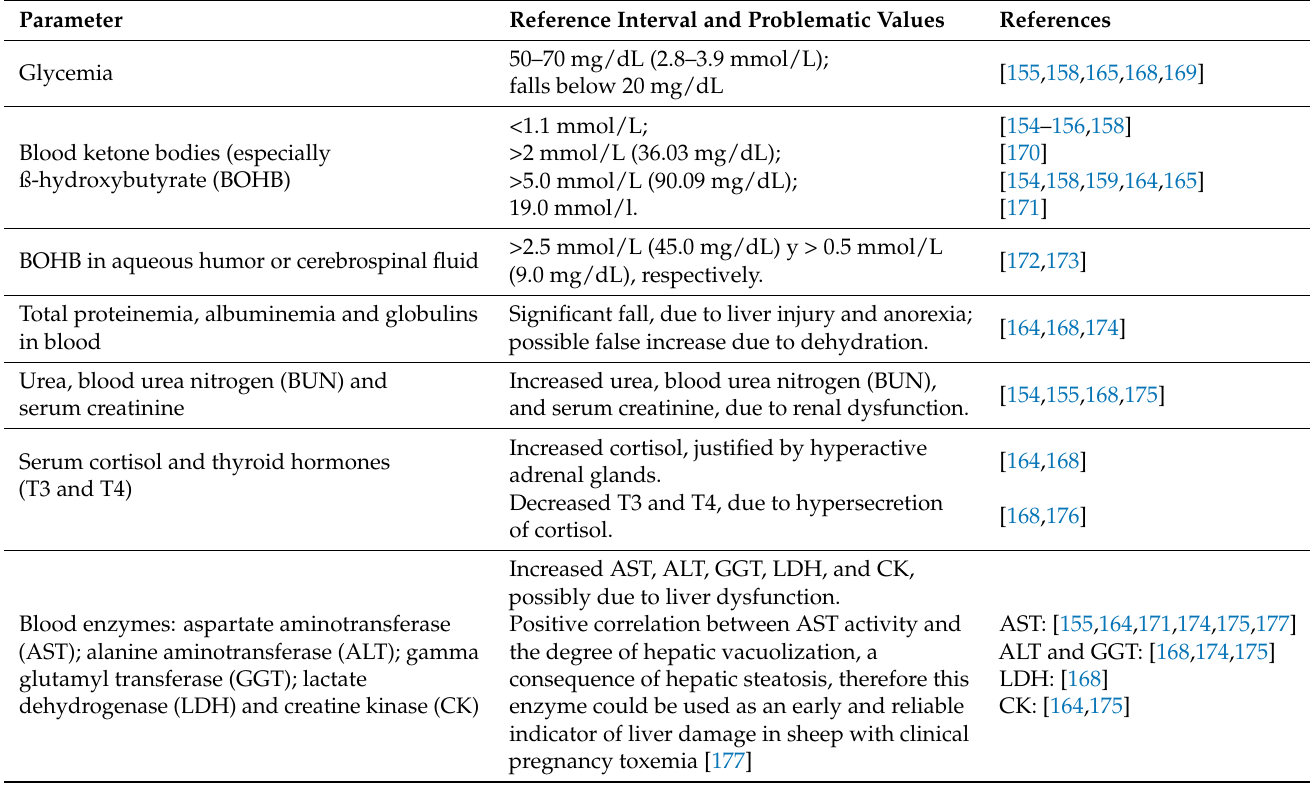
Table 2. Variables traditionally measured in the diagnosis of pregnancy toxemia in sheep and goats. Parameter Reference Interval and Problematic